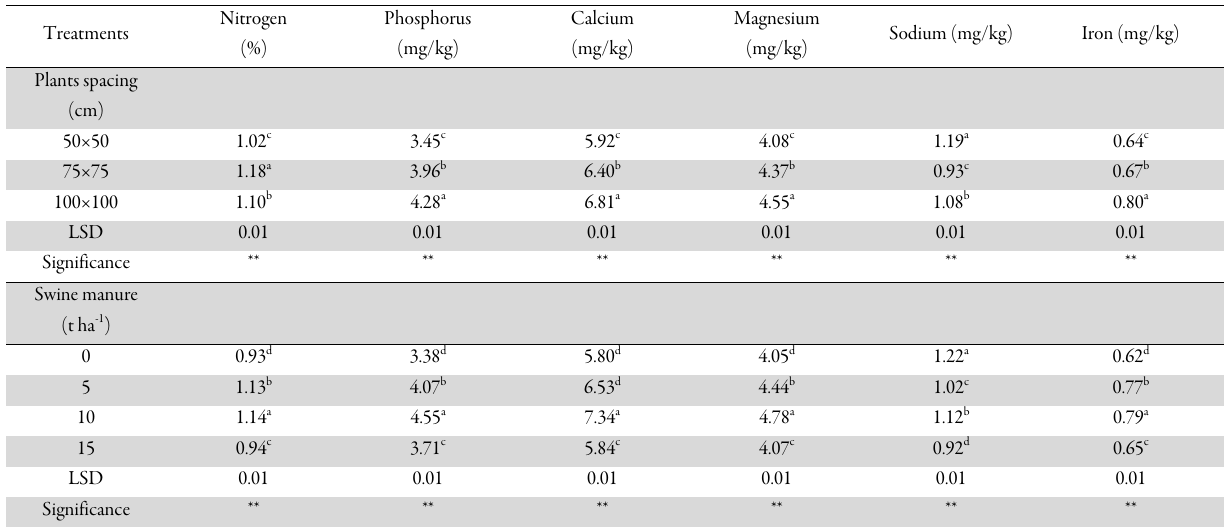
Table 5. Effects of spacing and levels of swine manure application on nutrient concentration of muskmelon